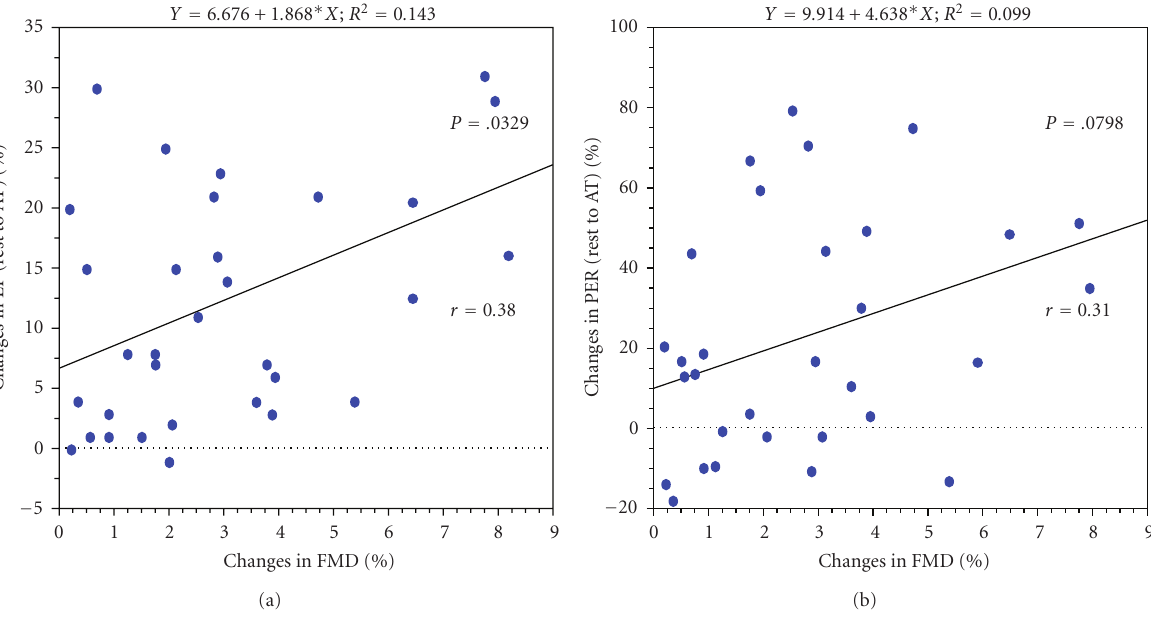
Figure 2: The correlation between flow-mediated vasodilation and cardiac response to exercise. FMD: flow-mediated vasodilation; EF: left ventricular ejection fraction; PER: peak ejection